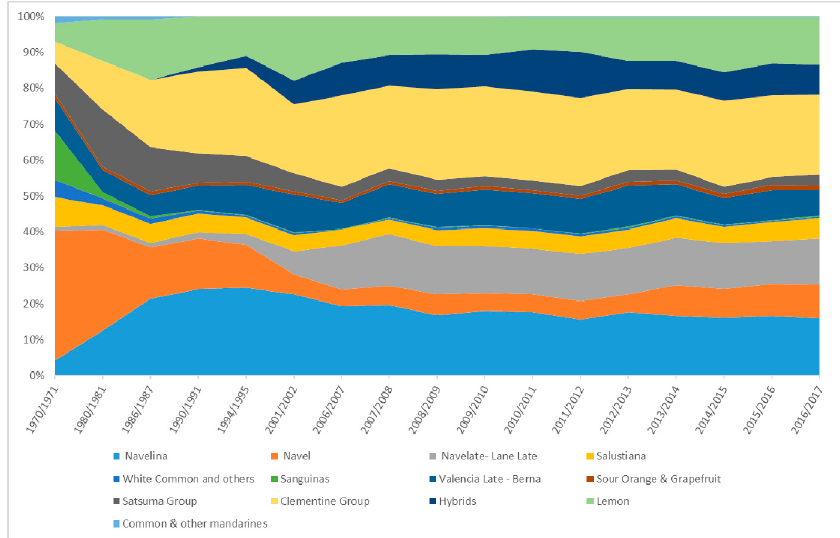
Figure 3. Progression of Spanish citrus production.